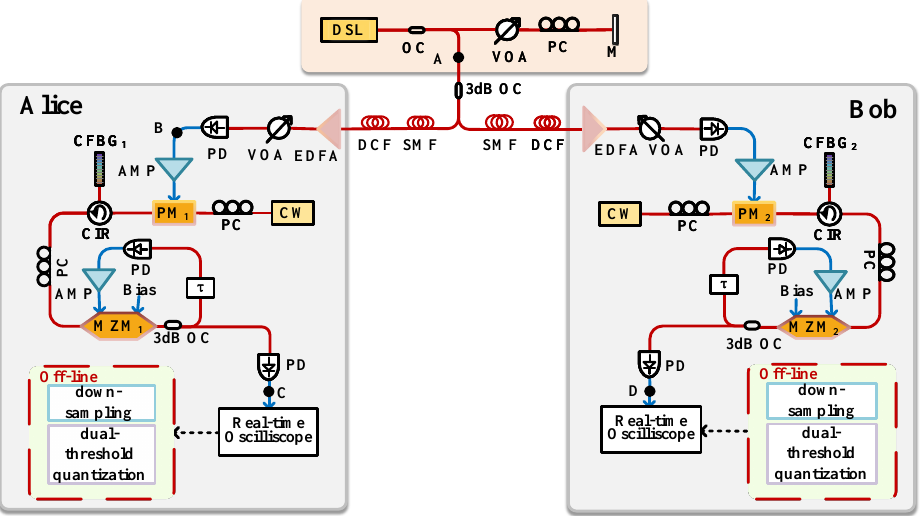
Figure 1. Schematic of correlated random bit generation. DSL: driving semiconductor laser. OC: op- tical coupler. VOA: variable optical attenuator. PC: polarization controller. M: mirror. SMF: single mode fiber. DCF: dispersion compensation fiber. EDFA: erbium-doped fiber amplifier. PD: